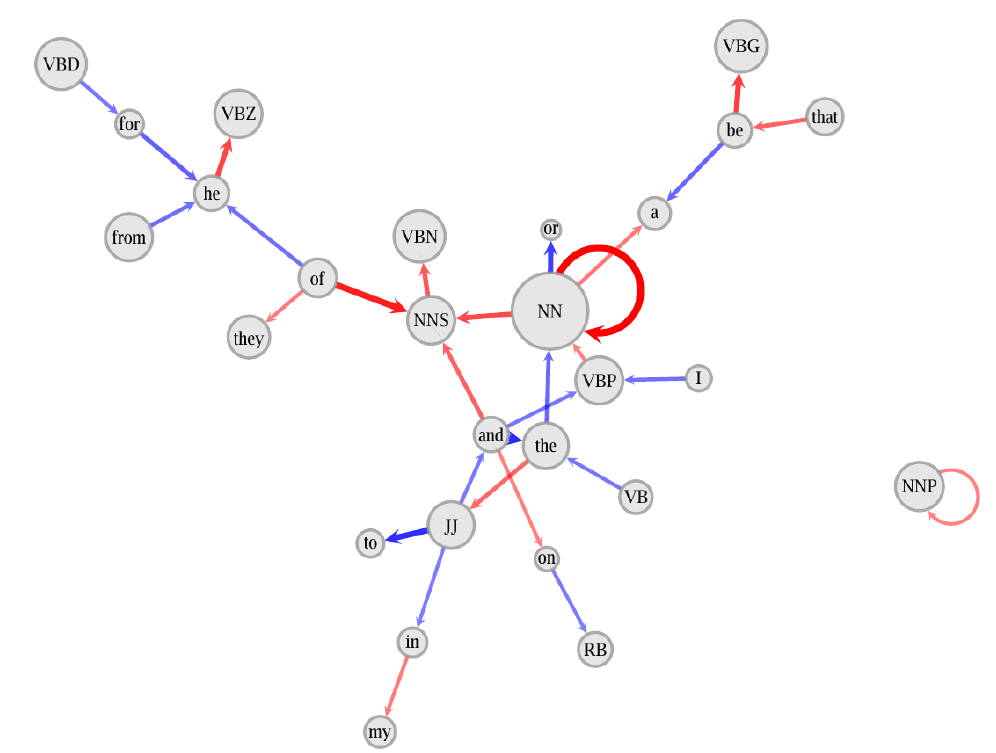
Figure 3. Comparative bigram graph for Stephen’s speech and thoughts. Blue arrows indicate over-representation in speech, red arrows indicate over-representation in